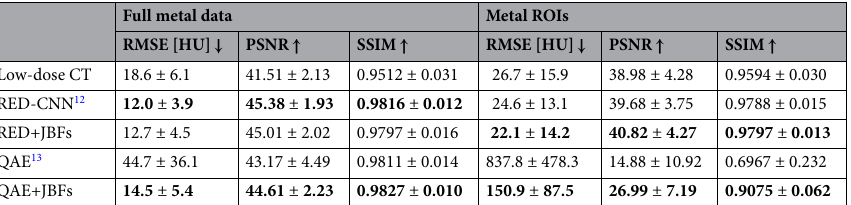
Table 1. Quantitative denoising results on the full abdomen scans containing metal implants as well as on 17 ROIs that contain metal parts. The metrics are averaged over all test patients or all test ROIs and provided as mean ± std . The respectively better performing network modification is highlighted in bold.